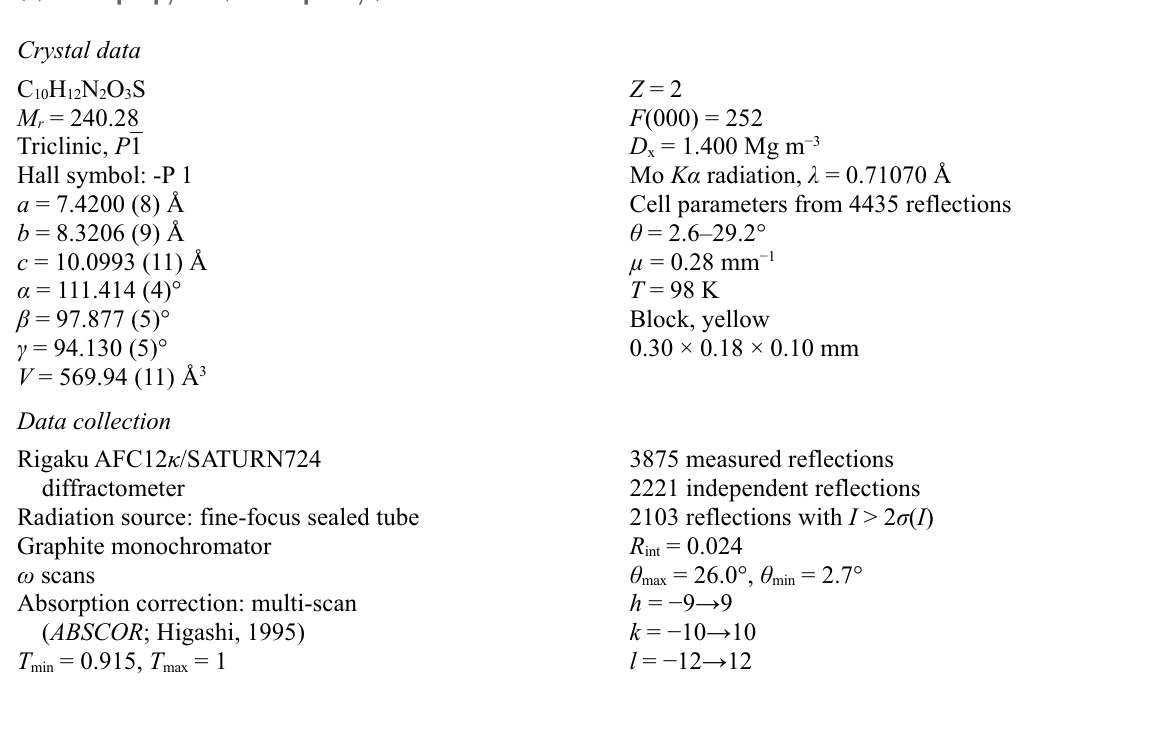
Figure 2 Crystal packing in (I) viewed down the a axis. N—H···S hydrogen bonding is shown as orange dashed lines. ( E )- O -Isopropyl N